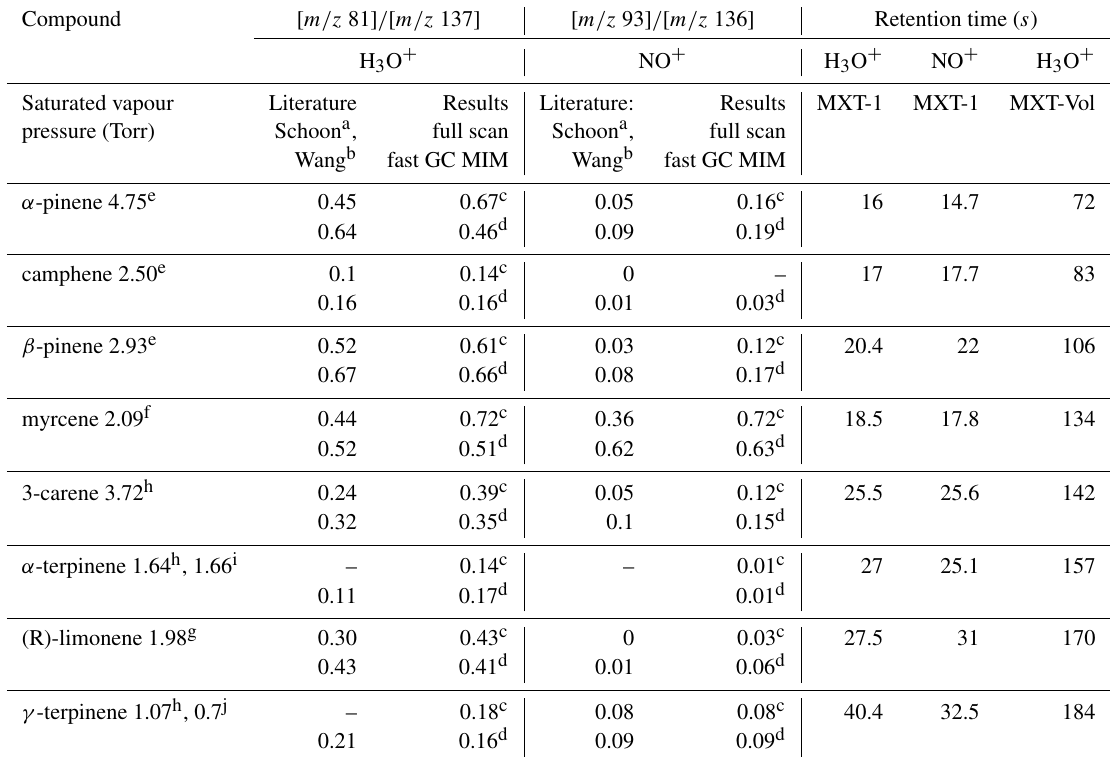
Table 2. Ratios of the H 3 O + and NO + reaction product ion signals and the GC retention times, s , for the eight monoterpenes at a column temperature of 40 ◦ C. Also given are the saturated vapour pressures (Torr). The standard error of the fast GC r w values for individual monoterpenes estimated by Eq. (3) is less than 5% (except 8.6% for camphene) and less than ± 0 . 02 overall.